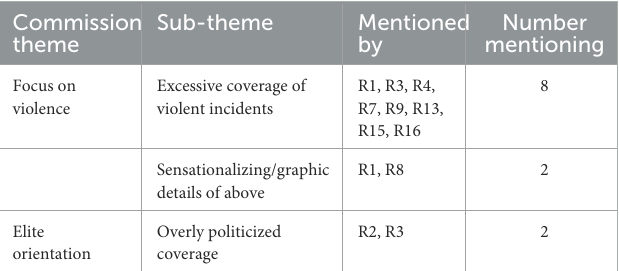
TABLE 4 Commission themes and